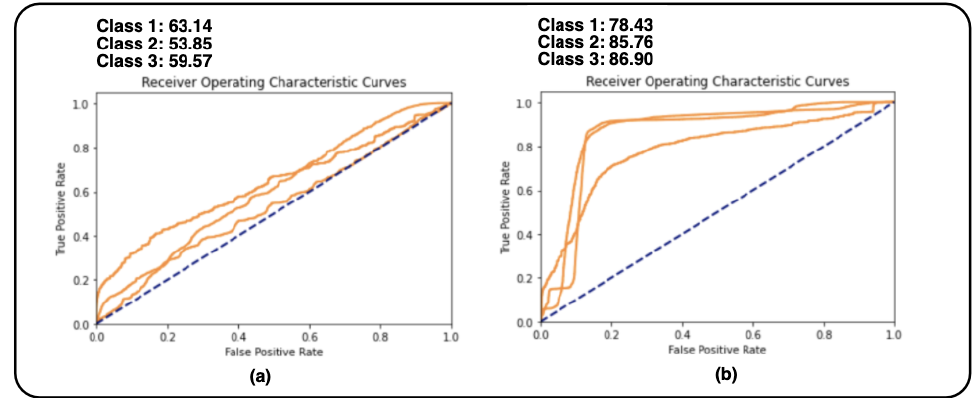
Figure 11. AUC-ROC curve performance of two support vector machine models with different parameters. ( a ) Support Vector Machine with poly kernel, one-vs-one function shape, and over- sampling technique. ( b ) Support Vector Machine with RBF kernel, one-vs-one function shape, and oversampling